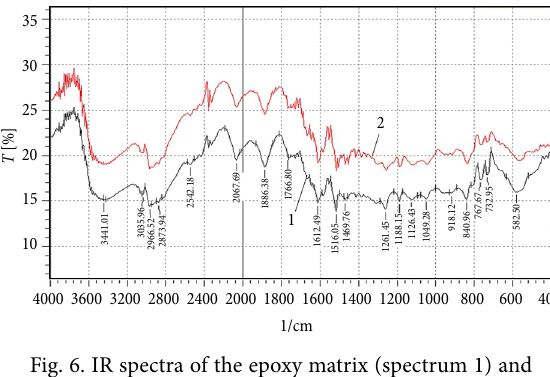
Fig. 6. IR spectra of the epoxy matrix (spectrum 1) and the composite with the MSKOS (spectrum 2) content of q = 0.050 pts. wt. in the range of wave numbers ν = 4000÷400 cm